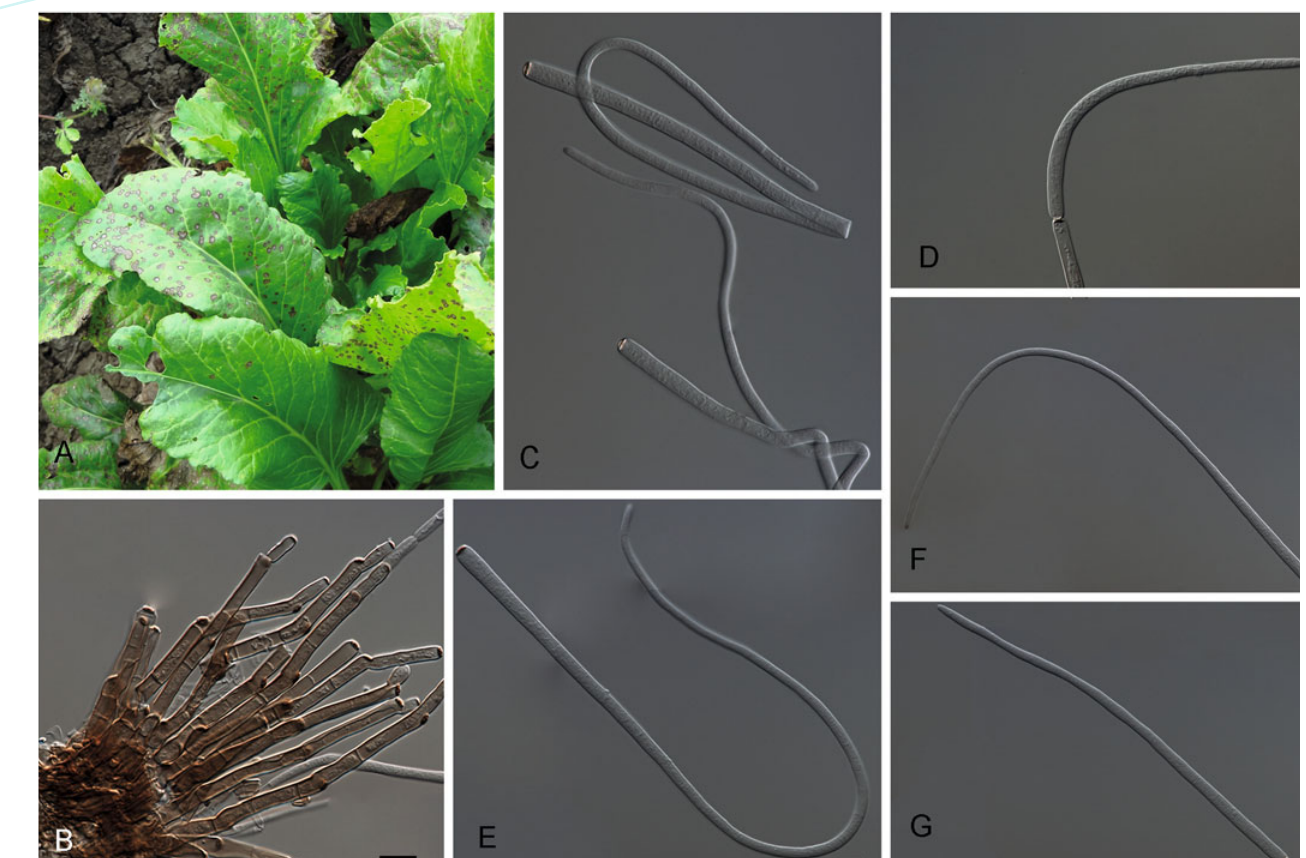
Fig. 6. Cercospora beticola (cid:24)%%<O(cid:2)!!.0(cid:27)(cid:28)(cid:2) A. (cid:2)S(cid:13)(cid:9)(cid:26)(cid:2)(cid:7)(cid:18)(cid:4)(cid:8)(cid:7)(cid:28)(cid:2) B. (cid:2)2(cid:9)(cid:7)(cid:19)(cid:11)(cid:19)(cid:5)(cid:23)(cid:9)(cid:8)(cid:13)(cid:2)(cid:19)(cid:4)(cid:17)(cid:11)(cid:21)(cid:11)(cid:4)(cid:18)(cid:14)(cid:4)(cid:10)(cid:13)(cid:7)(cid:28)(cid:2) C–G. (cid:2)%(cid:4)(cid:17)(cid:11)(cid:21)(cid:11)(cid:9)(cid:28)(cid:2)’(cid:9)(cid:10)(cid:7)(cid:2)(cid:134)(cid:2)!+(cid:2)_(cid:6)(cid:28)